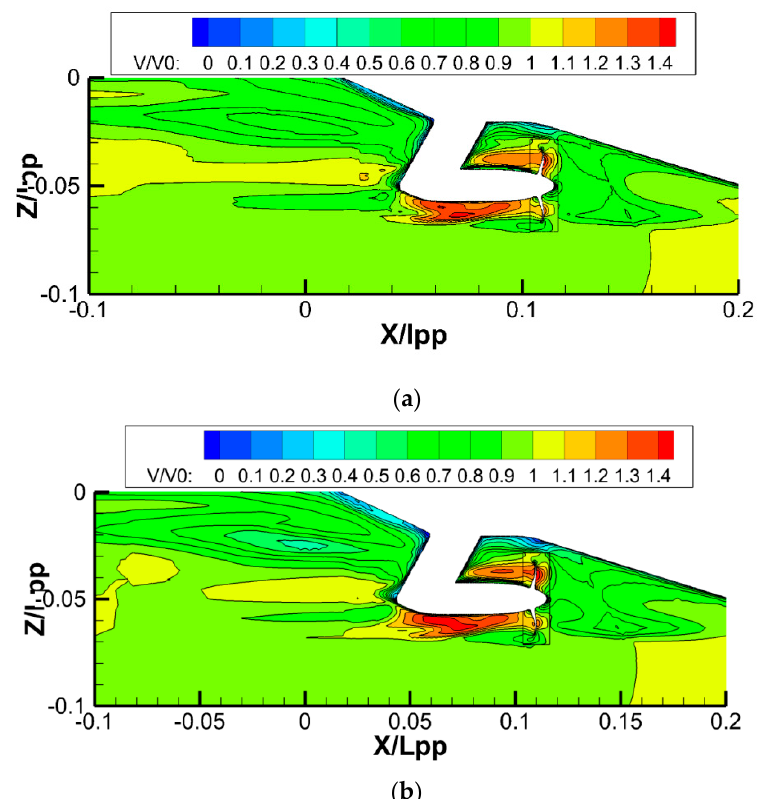
Figure 10. Flow field of the full-scale and the model-scale cases in the longitudinal section pertaining to Y/ L PP = 0.041: ( a ) Full scale ( b ) Model scale.